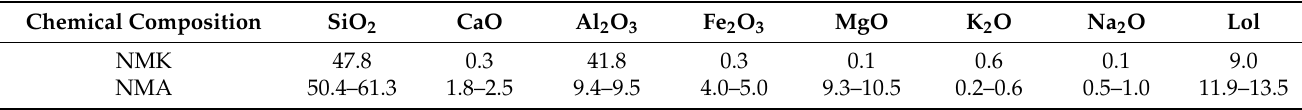
Table 1. Chemical composition of nanoclay (mass fraction, %).